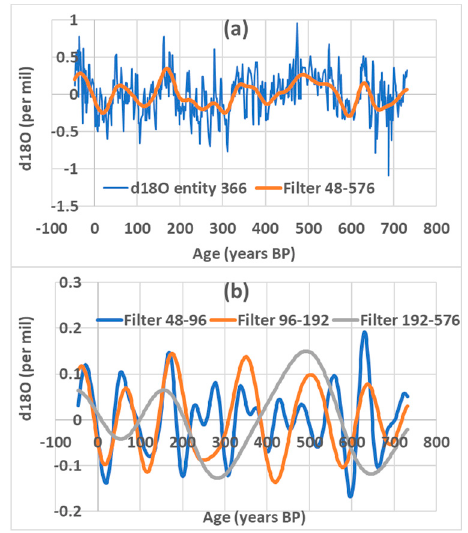
Figure 3. Filtering in subharmonic modes the speleothem (entity 366). ( a ) The raw data and filtered in the broad band 48–576 years (sum of components in ( b )); ( b ) speleothems are filtered in the characteristic bands 48–96, 96–192, and 192–576 years.